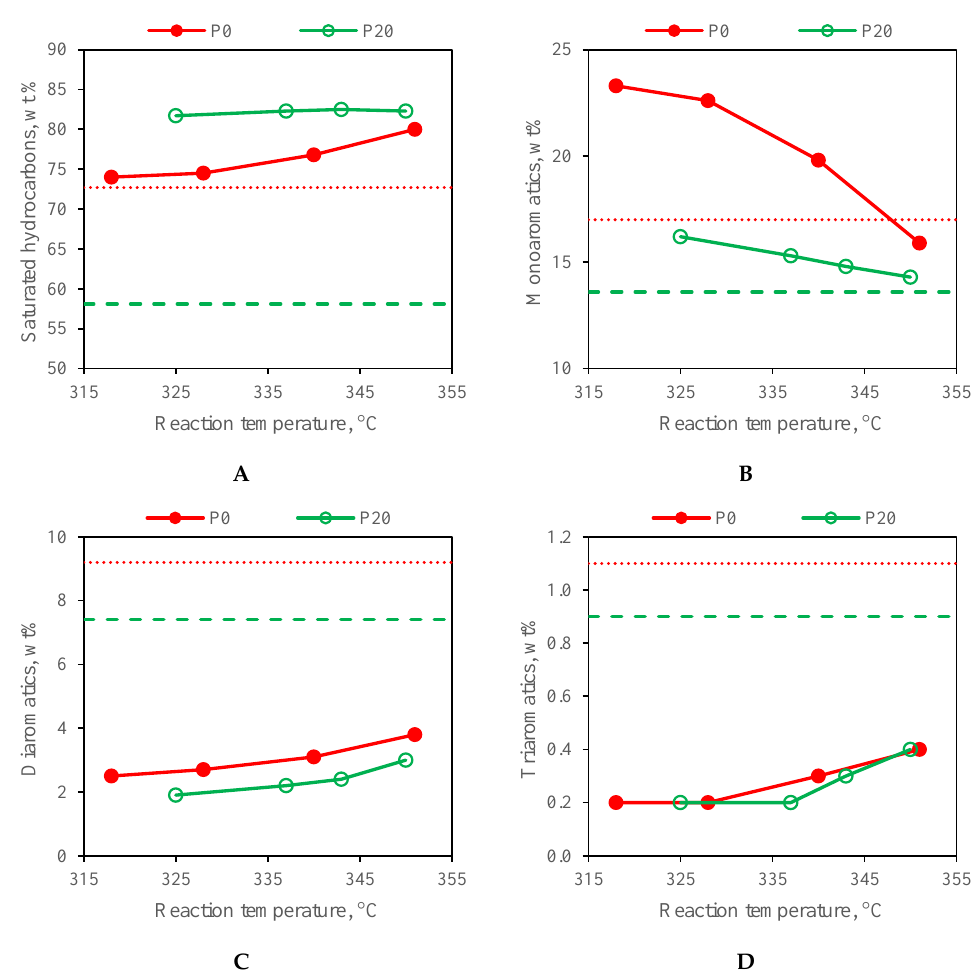
Figure 1. Group-type composition of both feedstocks (dashed lines) and all the liquid products (solid lines) obtained at a WHSV of 1.0 h −1 ( A ) saturated hydrocarbons; ( B ) monoaromatics; ( C ) diaromatics; ( D ) triaromatics. Table 1. The content of n-alkanes in the liquid products obtained at a WHSV of 1.0 h −1.